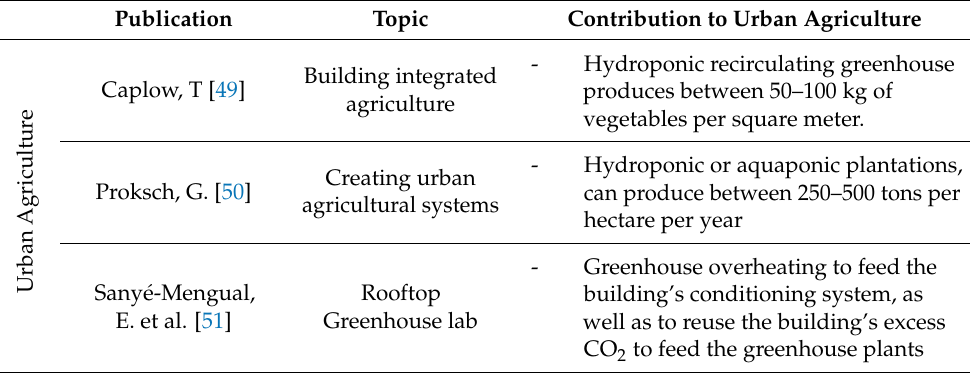
Table A6. Summary table of the contribution to urban agriculture (developed by the